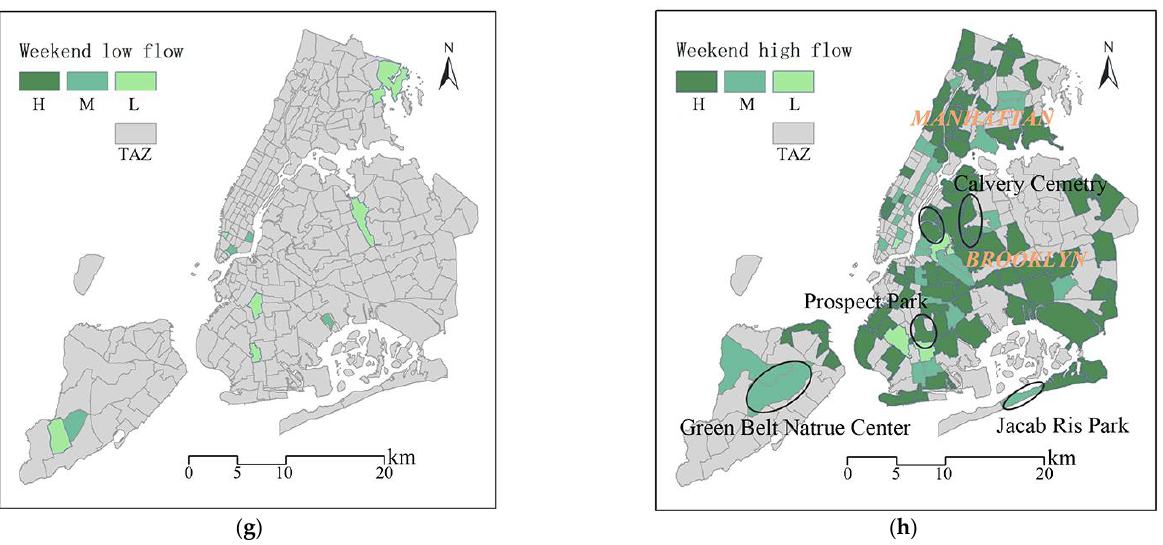
Figure 12. Changes in the stability of the internal travel flow for geographic units. ( a ) Low travel flow on weekdays in Shenzhen. ( b ) High travel flow on weekdays in Shenzhen. ( c ) Low travel flow on weekends in Shenzhen. ( d ) High travel flow on weekends in Shenzhen. ( e ) Low travel flow on weekdays in New York. ( f ) High travel flow on weekdays in New York. ( g ) Low travel flow on weekends in New York. ( h ) High travel flow on weekends in New York.